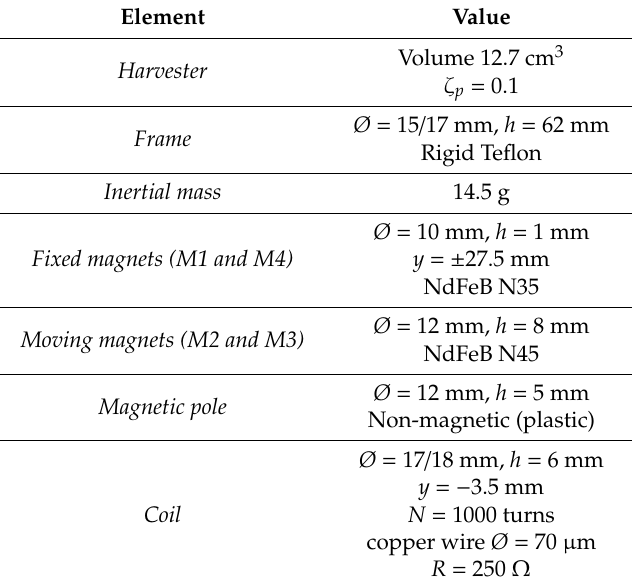
Table 1. Characteristics of the designed energy harvester prototype: ζ p is the parasitical damping ratio, Ø is the diameter (inner / outer), h the height, y is the vertical position of each element center considering y = 0 as the middle of the Teflon tube, N is the number of turns of the coil and R is its resistance.